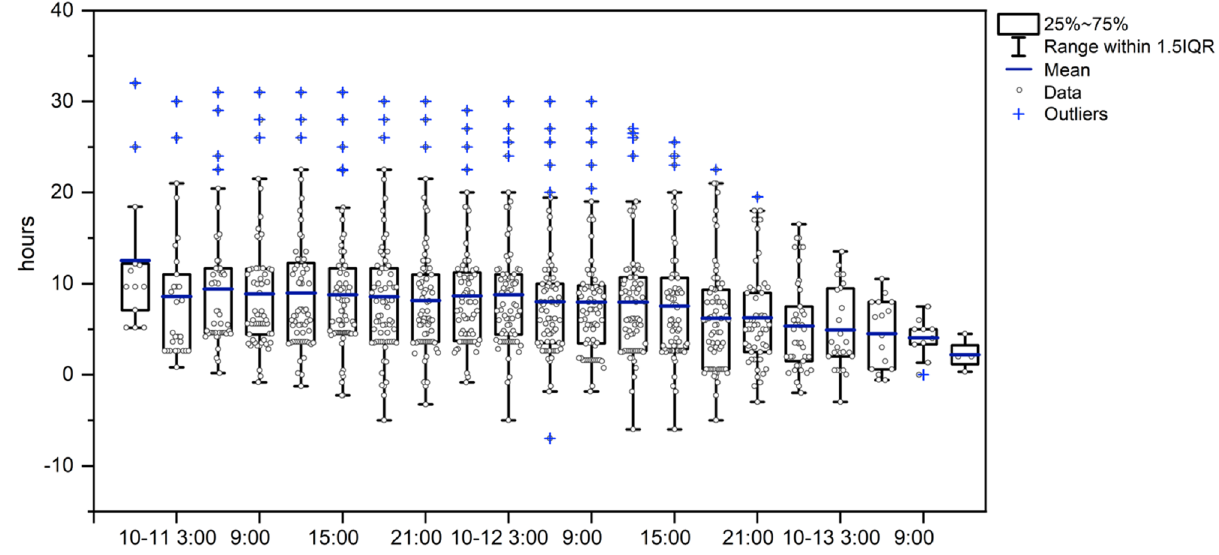
Figure 6. Difference between the predicted 1/200-year flood time and the DBT for each forecast for 80 TPWR locations. Quartile values and the mean across all TPWR locations are plotted for each estimation step.